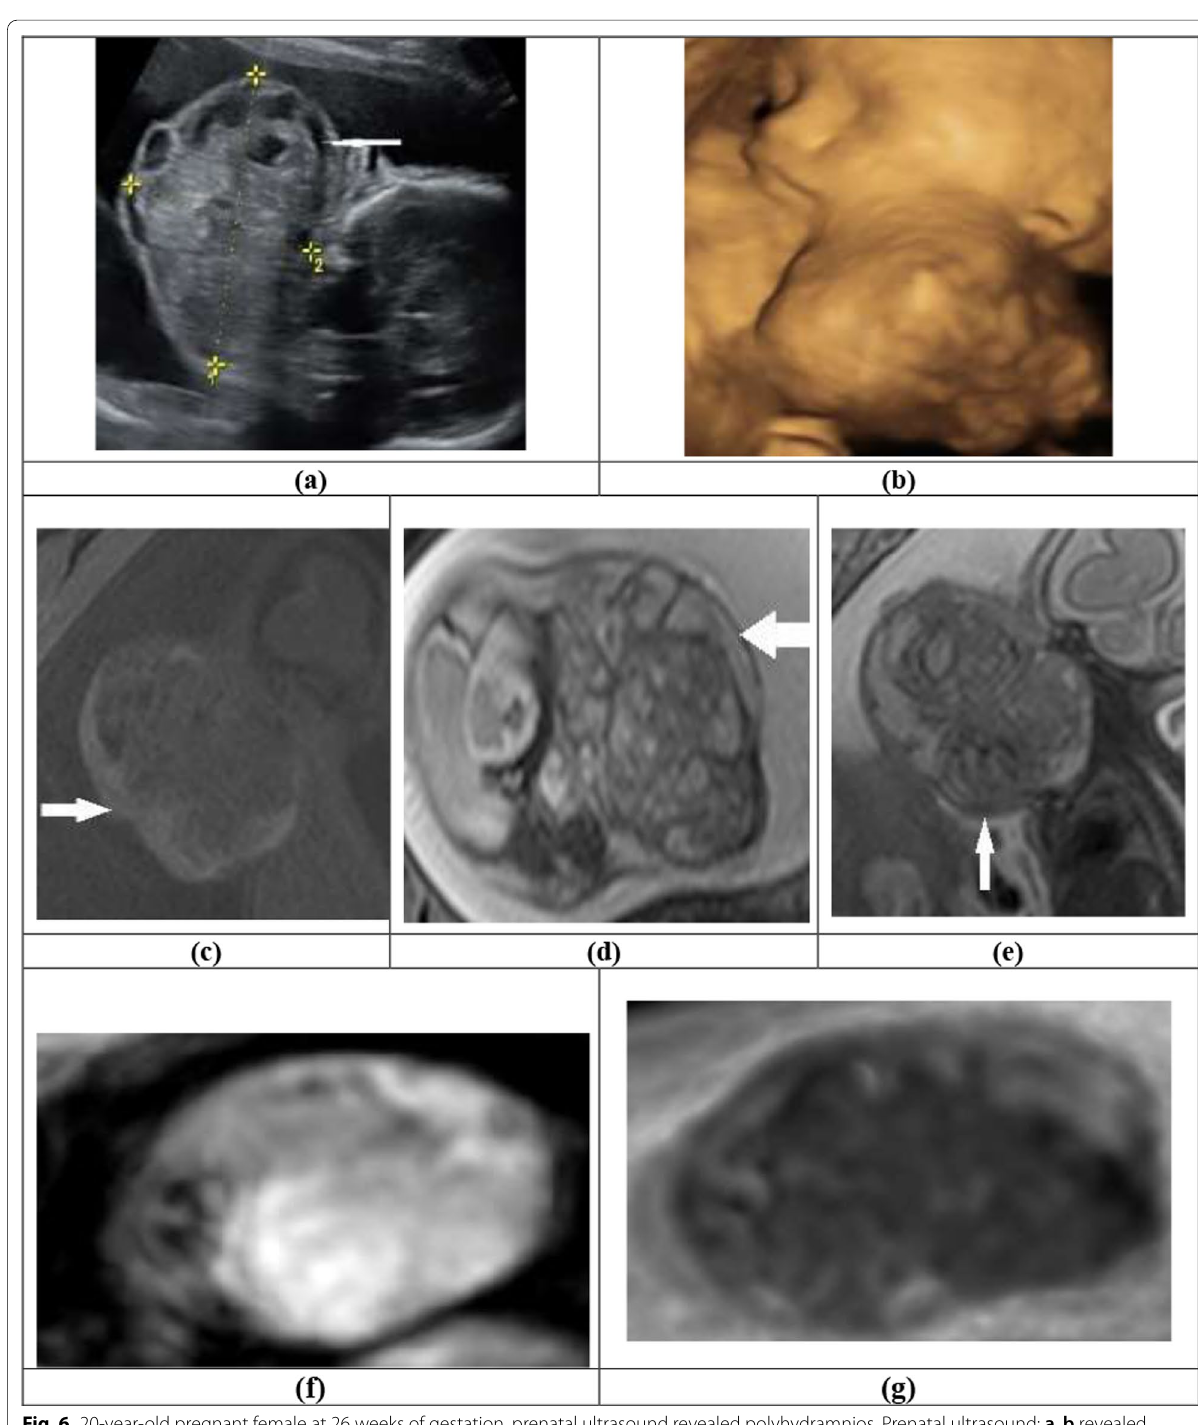
Fig. 6 20-year-old pregnant female at 26 weeks of gestation, prenatal ultrasound revealed polyhydramnios. Prenatal ultrasound: a , b revealed complex solid and cystic neck swelling (arrow) with no detected vascularity involving the left side of the neck …?cervical teratoma. Prenatal fetal MRI sequences revealed polyhydramnios and hyperextension of the neck and sizable neck swelling with solid and cystic changes (white arrow) with areas of hemorrhage (white arrow) seen compromising and obstructing the oropharyngeal airways with non-visualized stomach …matching with congenital cervical teratoma: c sagittal T1-weighted image, d axial T2-weighted SSFSE sequence, e sagittal T2-weighted SSFSE sequence, f DWI, g ADC image. Diagnosis was congenital cervical